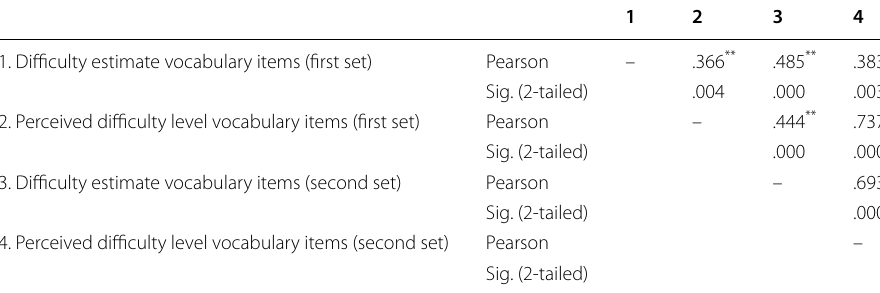
Table 2 Pearson’s product moment correlation of difficulty estimates and perceived difficulty level (vocabulary